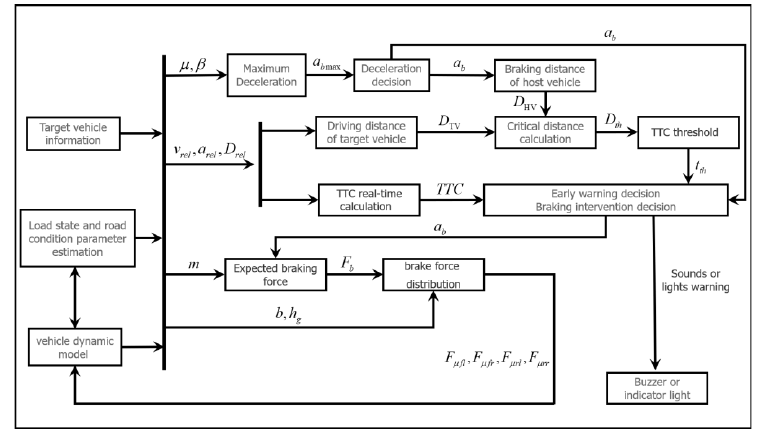
Figure 11. AEBS decision layer control strategy architecture.